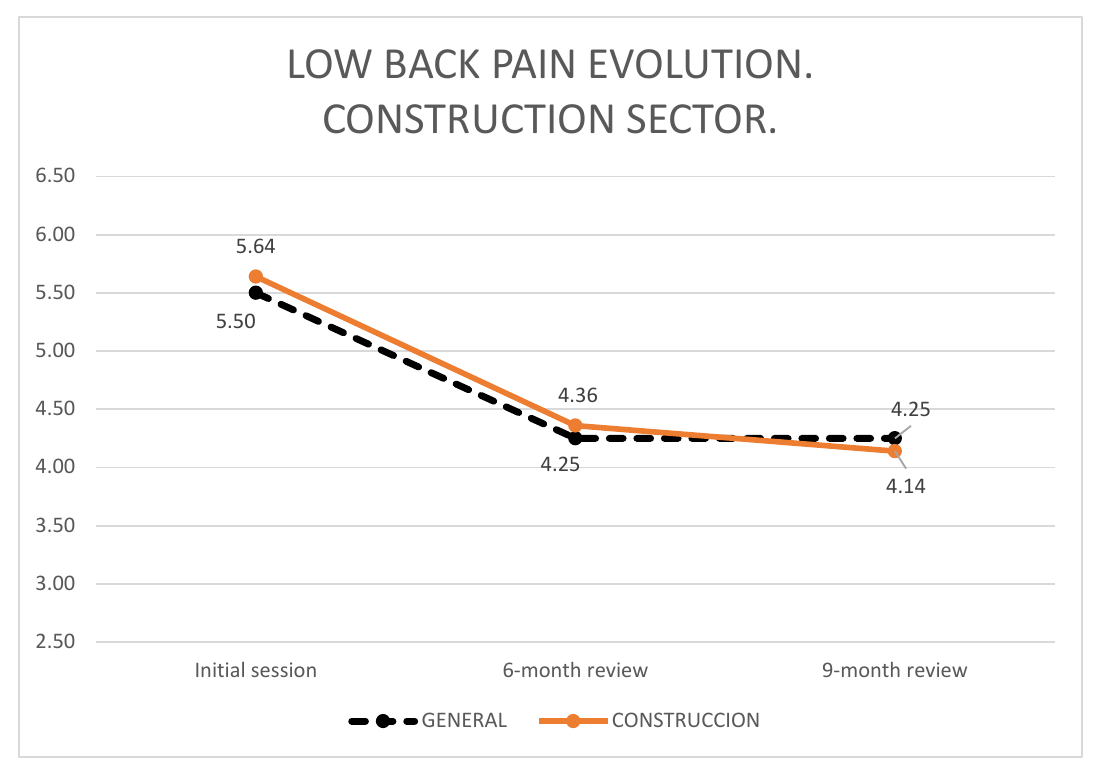
Figure 3. Questionnaires administered in the first BS session.